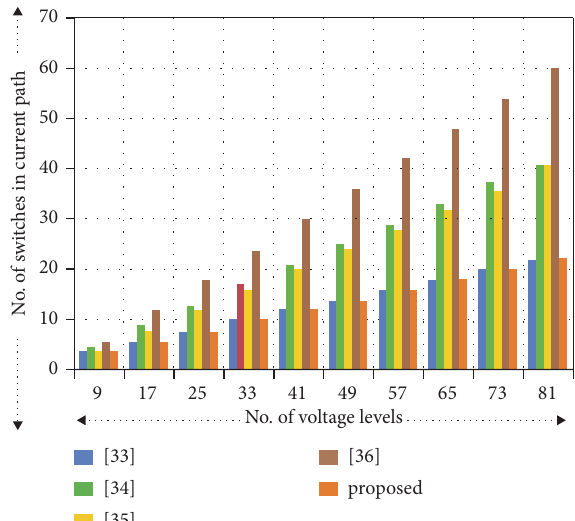
Figure 10: Comparison of number of switching device required for various voltage levels in recent topologies vs. proposed topology.